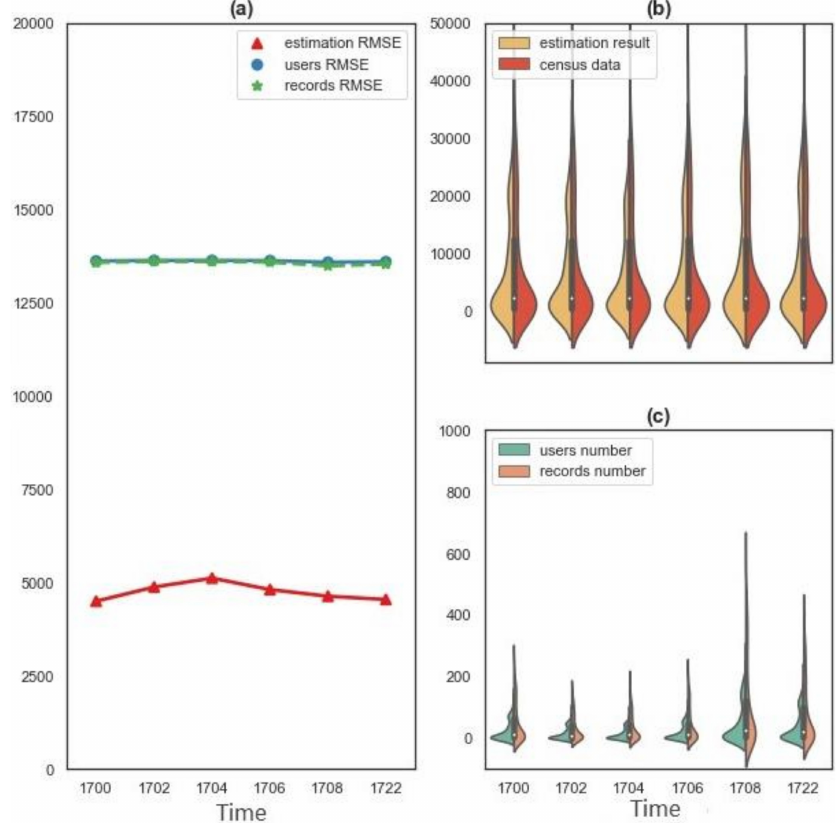
Figure 18. The comparison of D1, D2 and D3 results: ( a ) shows the RMSEs (Y-axes) for three comparison: estimation and the census data, users and census data, records and census data; ( b ) shows the estimation result of population density compared to the census data; ( c ) illustrates the single-users-used result compared to the single-records-used result. ( b ) and ( c ) share the same x